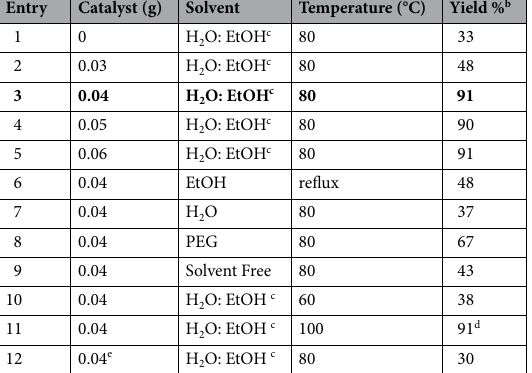
Table 3. Optimization for the synthesis of tetrahydrobenzo[b]pyran with 4-chlorobenzaldehyde, malononitrile, dimedone and HMS/Pr-Xa-Ni as catalyst a . a 4-Chlorobenzaldehyde (1 mmol), malononitrile (1 mmol), dimedone (1 mmol), 45 min. b Pure yield. c Ratio: 3:1 mL. d 40 min. e The reaction catalyzed by HMS/ Pr-Xa. Significant values are in